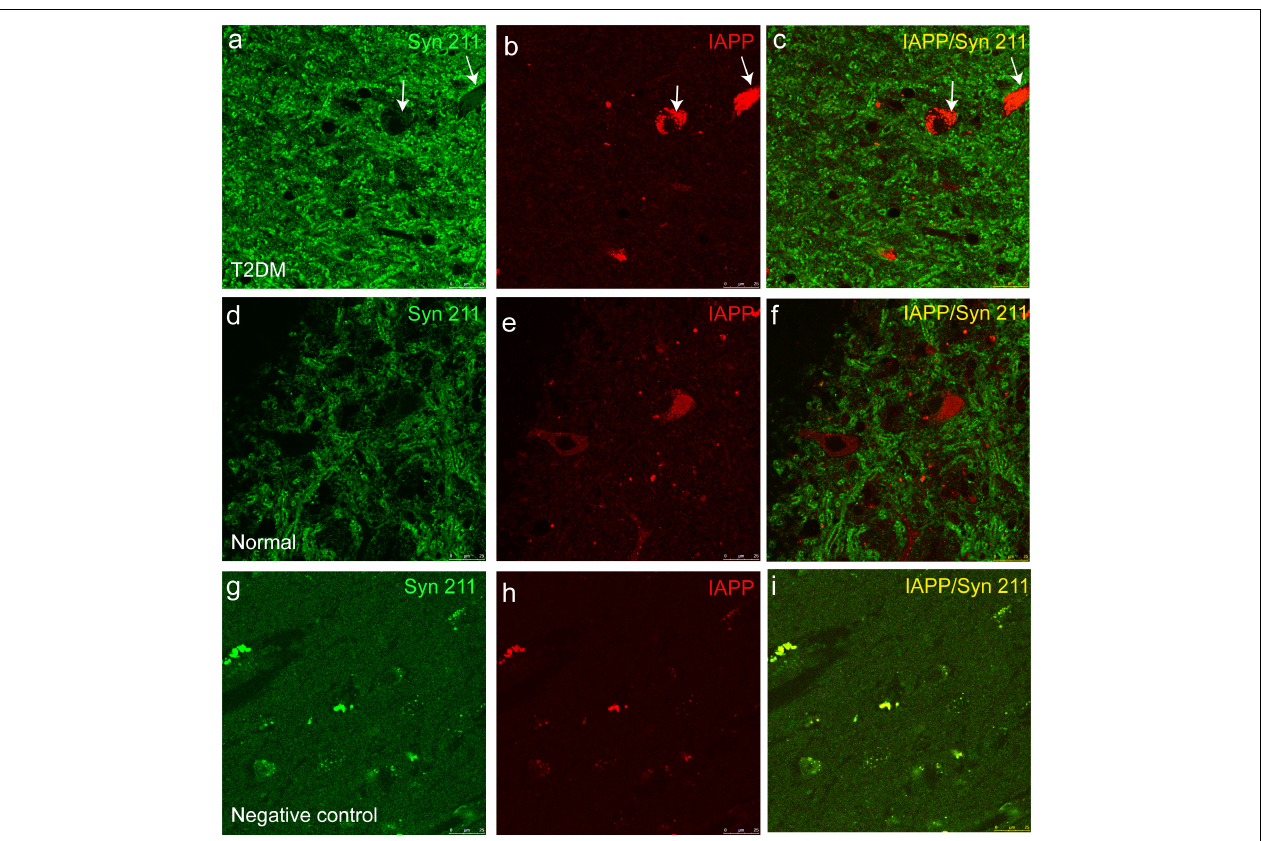
FIGURE 5 | Dual immunofluorescence images for IAPP and α -synuclein (Syn 211) in the substantia nigra. The α -synuclein antibody (a,d) and an IAPP antibody (b,e) were used to stain the sections of the substantia nigra in a diabetic monkey ( a–c , ID:DM940790) and a normal monkey (d–f) , ID:N942303) and a negative control (i.e., incubation without the primary antibodies) from the diabetic monkey ( g–i , ID:DM940790). Arrows pointed the dopaminergic neurons containing detectable amounts of α -synuclein and IAPP. The fluorescent profiles in (g–i) are non-specifically stained structures containing autofluorescence. Scale bar = 25 µ